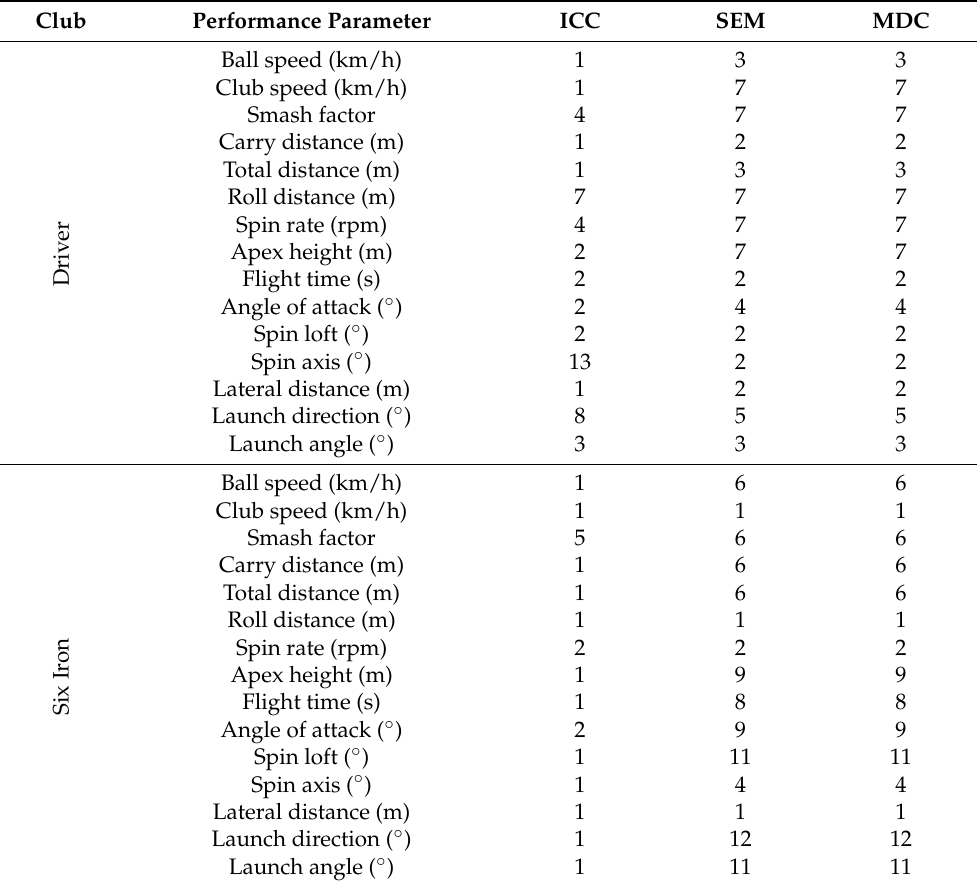
Table 3. Number of shots required for the calculation of each performance parameter depending on the reliability index